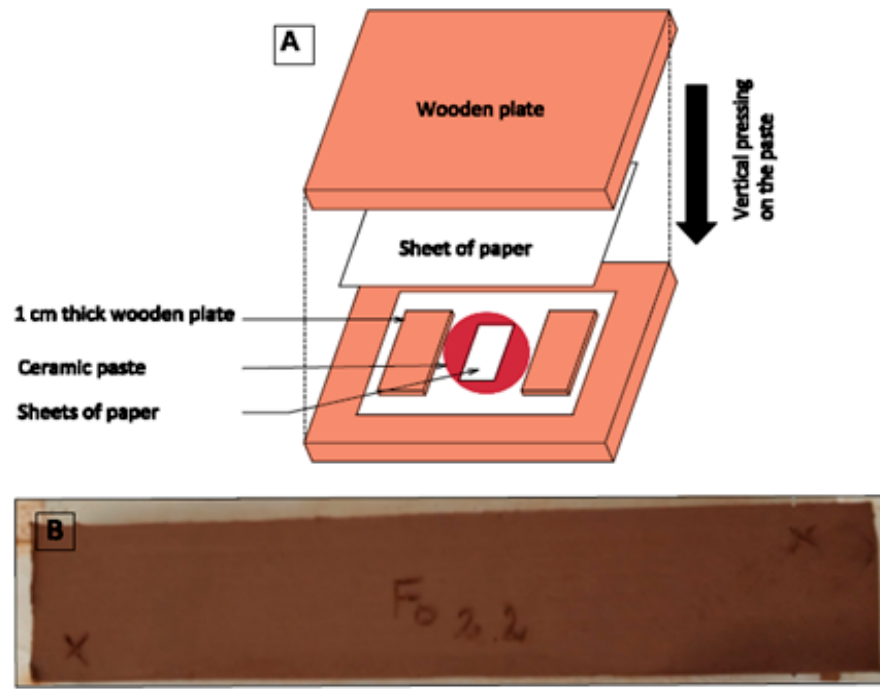
Figure 2. ( A ) Device for producing test pieces using the plate method. ( B ) Example of a specimen with two reference crosses for measuring the shrinkage.